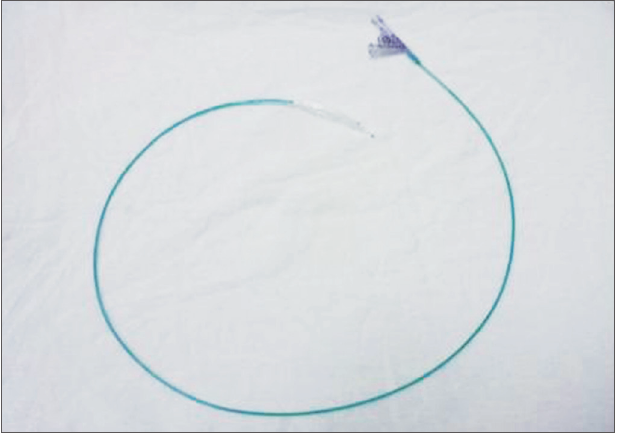
Figura 1. Cateter de angioplastia usado nas laringoplastias com balão. Visualizava-se, então, a subglote com a óptica